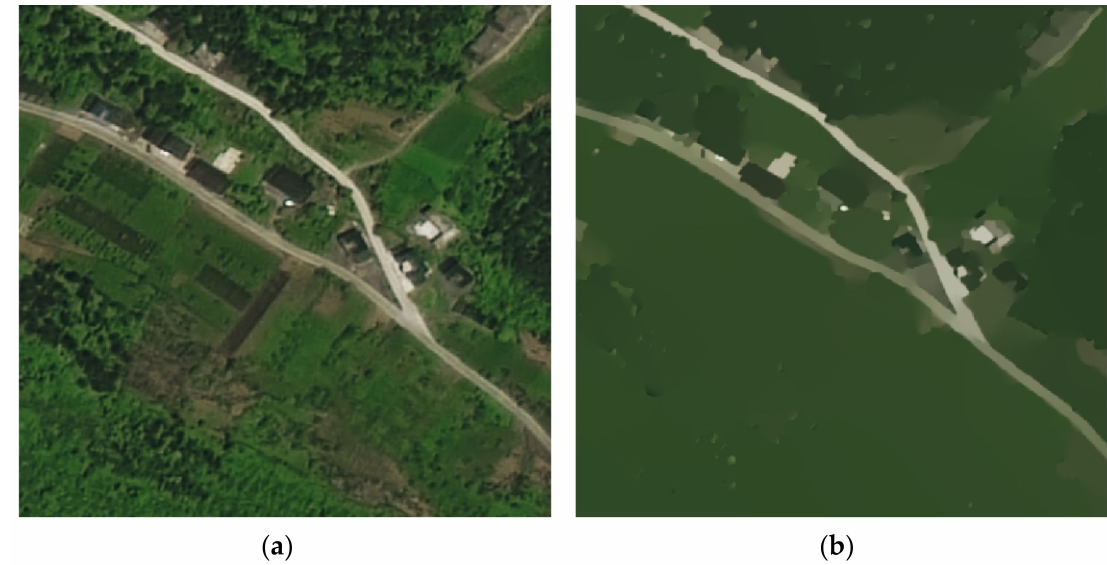
Figure 3. L0 filter effect comparison. ( a ) The original image. ( b ) Image after L0 filter.